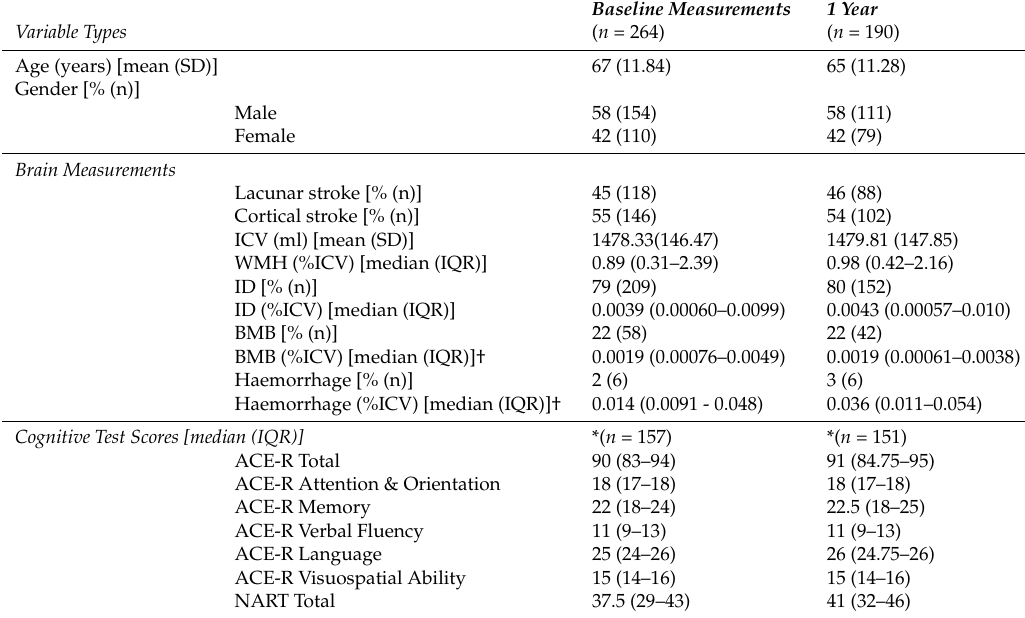
Figure 1. Box plots and distributions of the main imaging and cognitive variables analyzed: Striatal (mainly basal ganglia) iron deposition, brain microbleeds, Revised Addenbrooke’s Cognitive Examination, and the National Adult Reading Test. Table 1. Descriptive statistics of the total sample at diagnosis/first wave of cognitive testing, and 1 year after (follow-up). For simplification of tabular presentation, percentages (%) are rounded to the closest integer number (elsewhere, test percentages are shown up to two significant decimal places).